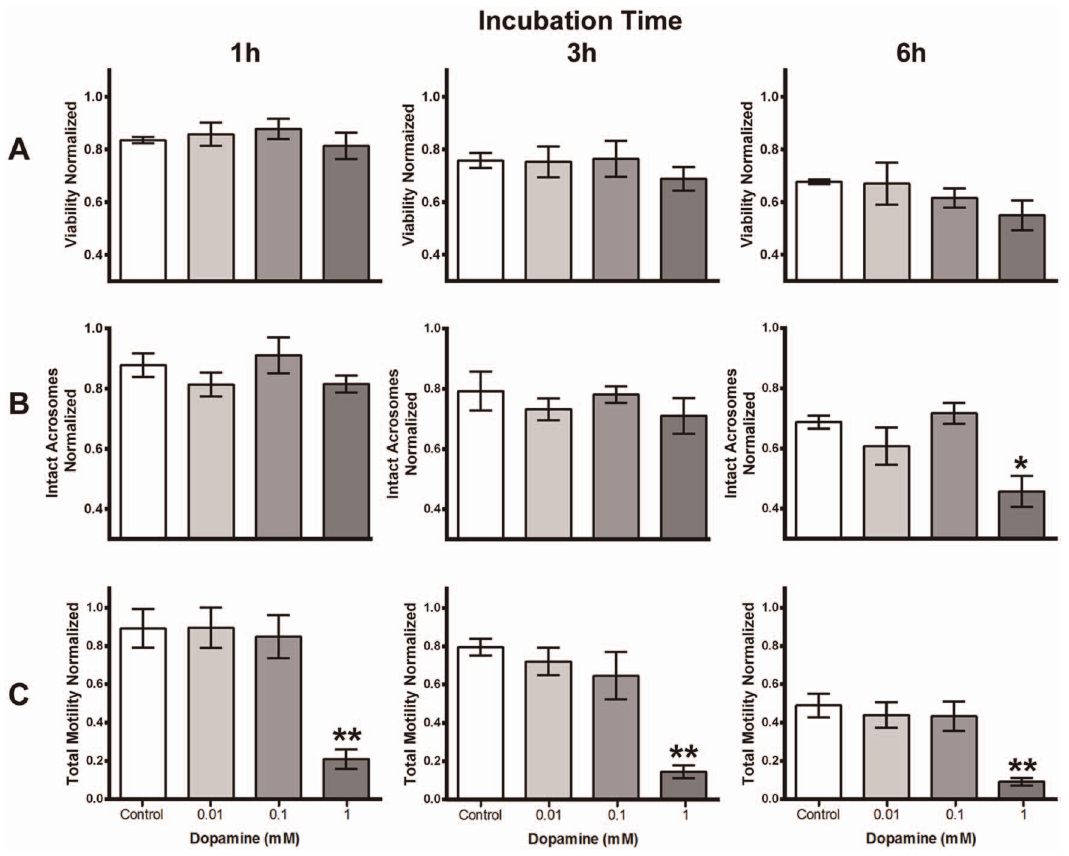
Figure 3. High doses of dopamine reduce sperm motility and acrosomal integrity without affecting the sperm viability over time. A) Effect of dopamine on sperm viability at 1, 3 and 6 hours of incubation. Equine sperm were incubated at 37 u C with different concentrations of dopamine (0, 0.01, 0.1 and 1 mM) in Withenn’s buffer and the quantity of viability sperm was calculated using a CASA system, with a minimum of 500 sperm analyzed per experiment. Sperm viability at different times of analysis was normalized to time zero of the control. Results are the mean 6 SEM of four independent experiments. B) Effect of dopamine on acrosomal integrity after 1, 3 and 6 hours of incubation. Equine sperm were incubated at 37 u C with different dopamine concentrations (0, 0.01, 0.1 and 1 mM) in Withenn’s buffer (enrichment with BSA and bicarbonate) and the percentage of sperms with intact acrosomes was assessed with PSA-FITC staining and by cell count under an epifluorescence microscope. A minimum of 200 sperm were counted. The percentage of intact acrosomes was normalized to time zero of the control without dopamine. Results are the mean 6 SEM of four independent experiments. *p , 0.05 with respect to the control. C) Effect of dopamine on total sperm motility after incubation for 1, 3 and 6 hours. Equine sperm were incubated at 37 u C with different concentrations of dopamine (0, 0.01, 0.1 and 1 mM) in Withenn’s buffer and the quantity of mobile sperm was calculated using a CASA system. A minimum of 500 sperm were analyzed per experiment. Total motility at different times of analysis was normalized to time zero of the control. Results are the mean 6 SEM of four independent experiments. **p , 0.01 with respect to the control.